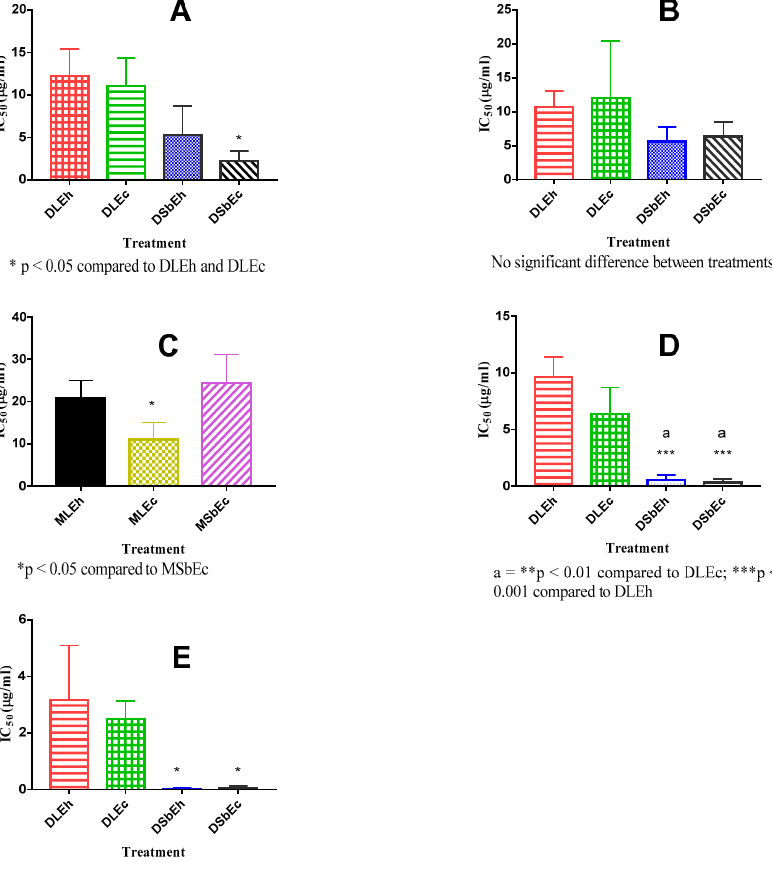
Figure 2. Comparison of IC 50 of hot and cold DCM and methanol extracts of leaf and stem bark against KYSE 70, SiSo, HepG2 and 5637 cell lines. ( A ) = KYSE 70 cell line, ( B , C ) = SiSo cell line, ( D ) = HepG2 cell line, ( E ) = 5637 cell line. Values are mean ± SEM ( n = 3) one-way ANOVA. (Tukey’s multiple